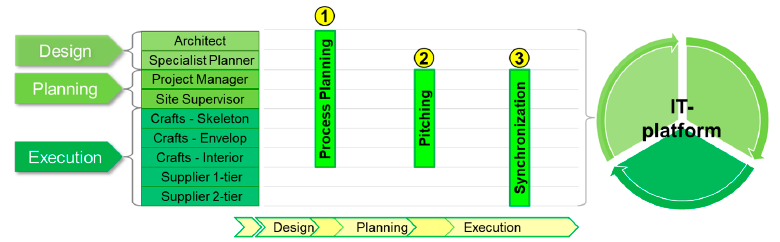
Figure 3. Collaborative planning and construction.